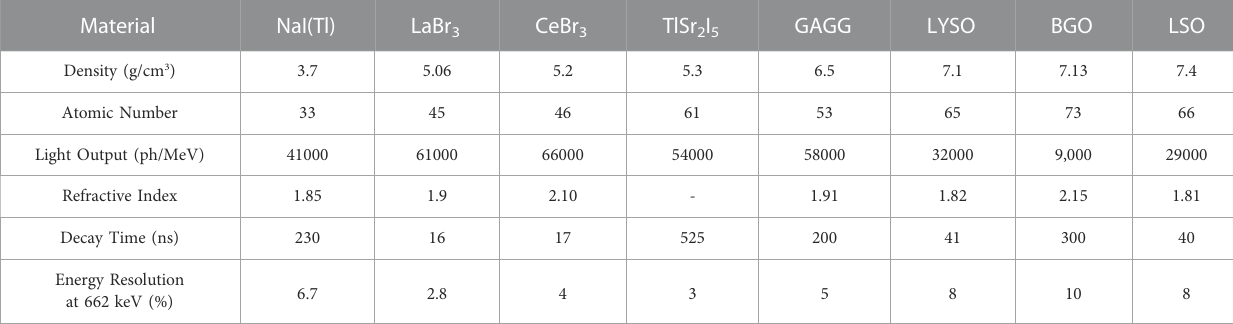
TABLE 1 Material properties for various scintillator materials. Data taken from Refs. [4, 31 – 40].